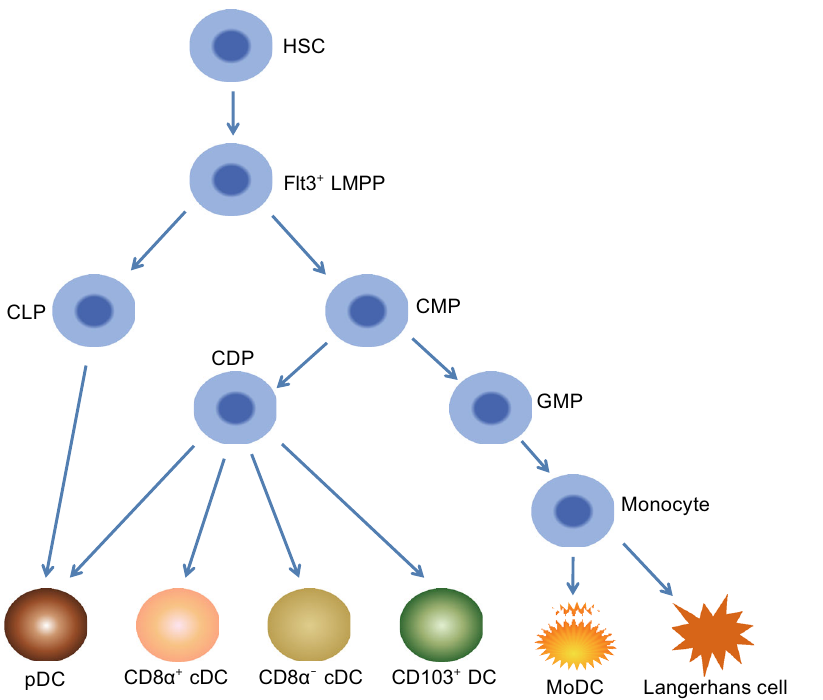
Figure 2. The development of different DC subsets. All DC subsets are derived from Flt3 + LMPP. CD8 α + cDC, CD8 α − cDC and CD103 + DC originate from CMP and CDP. pDC are differentiated from CLP, CMP and CDP. Langerhans cells and moDC are from